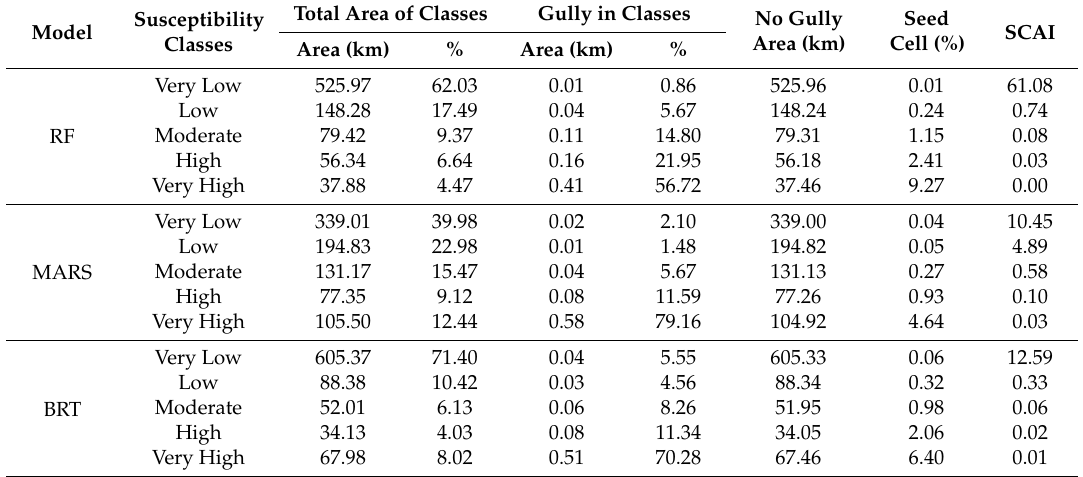
Figure 7. Seed cell area index (SCAI) values for different susceptibility classes in RF, MARS, and BRT data mining models. Table 7. Seed cell area index (SCAI) values in RF, multivariate adaptive regression spline (MARS), and boosted regression tree (BRT) data mining